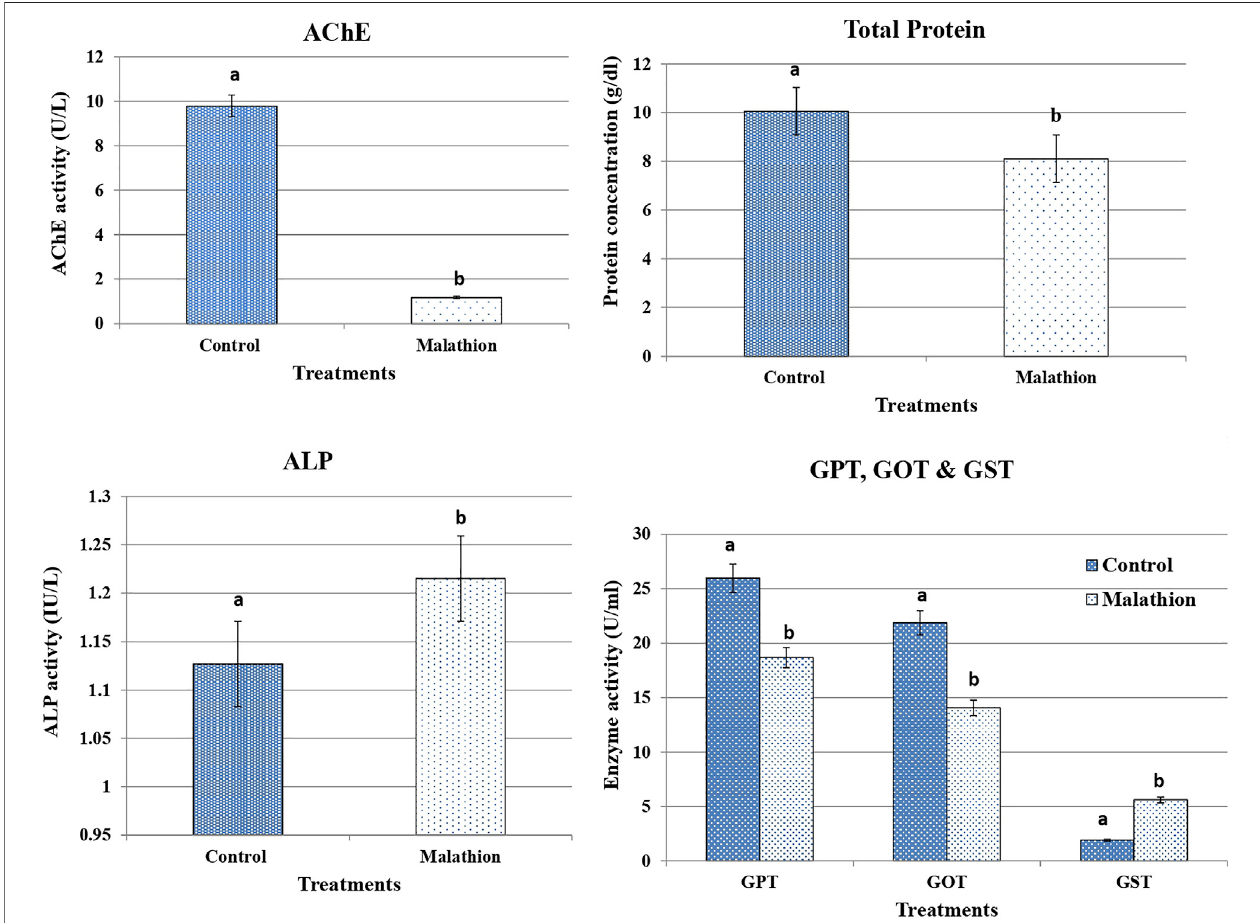
FIGURE 2 | Effect of malathion on AChE, total protein, ALP GPT, GOT, and GST in male rats after 21 days of treatment compared to control. Bars represent means ± SD. * p < 0.05 versus control. Different letters (A,B) indicate the signi fi cant differences between means according to Duncan ’ s multiple range test.